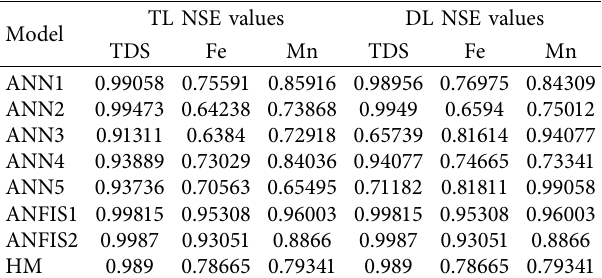
Figure 10: Results of the ANN, ANFIS, and hydraulic models. (a) Values of NSE for DL ANN, (b) values of NSE for TL, (c) values of MSE for DL ANN, (d) values of MSE for TL ANN, (e) predicted versus recorded TDS, (f) predicted versus recorded Fe, and (g) predicted versus recorded Mn. Table 6: NSE values for DL and TL ANN